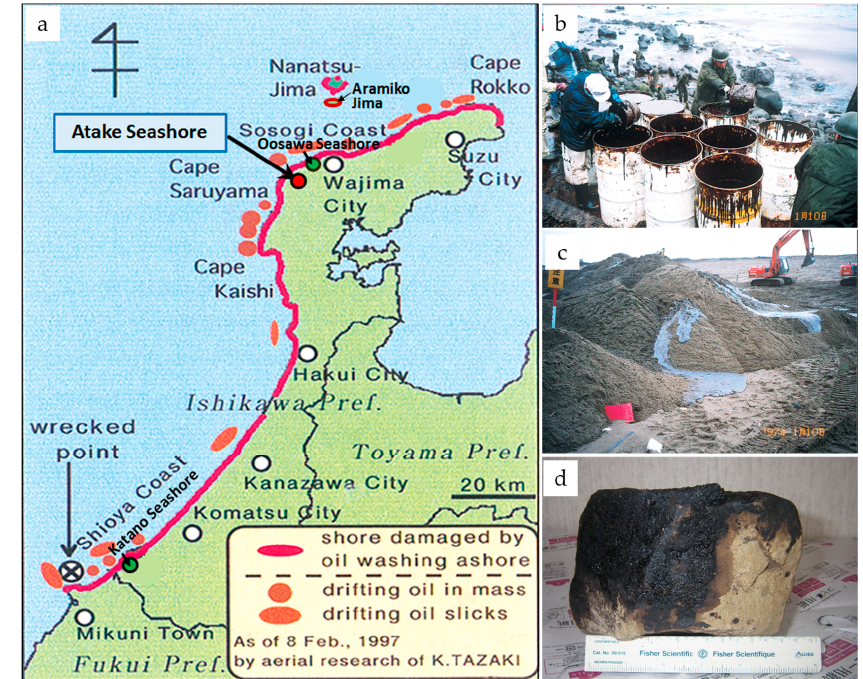
Figure 1. Distribution map of heavy oil from the Nakhodka oil spill-polluted seashores in the Sea of Japan on 8 February 1997 by the aerial research of Tazaki (1997) [1] ( a ); collected heavy oil in drum-cans at seashores in Sakai (Mikuni), Fukui, Japan in 1997 ( b ); collection of heavy oil on the sandy beach in 1997 ( c ); and a rock sample covered by heavy oil changed to paraffin wax after nine years in 2005 ( d